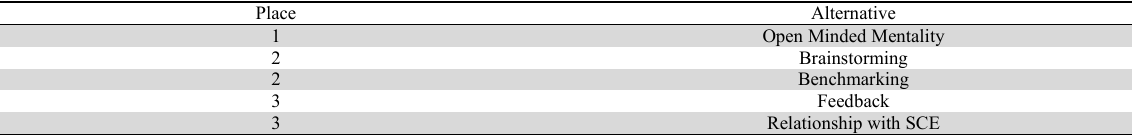
Ascend distillation matrix (Final Situation)